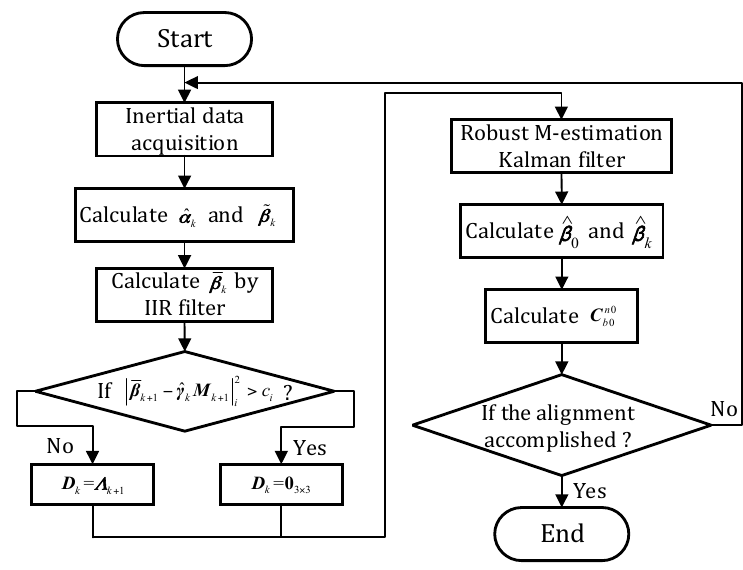
Figure 5. The flow diagram of algorithm.